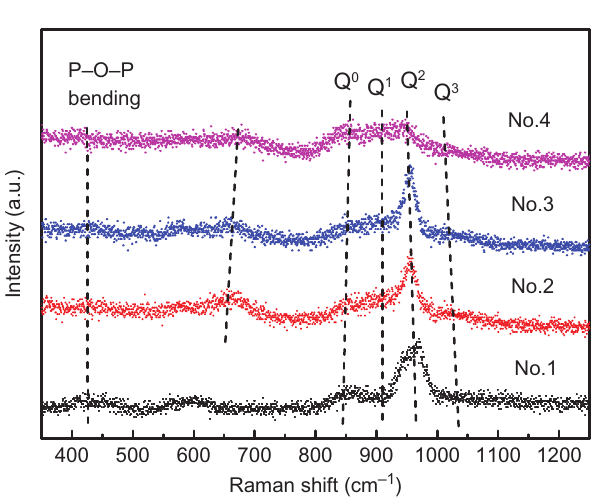
Figure 4: Effect of slag basicity on (a) Q n (Si) and (b) Q n (P).